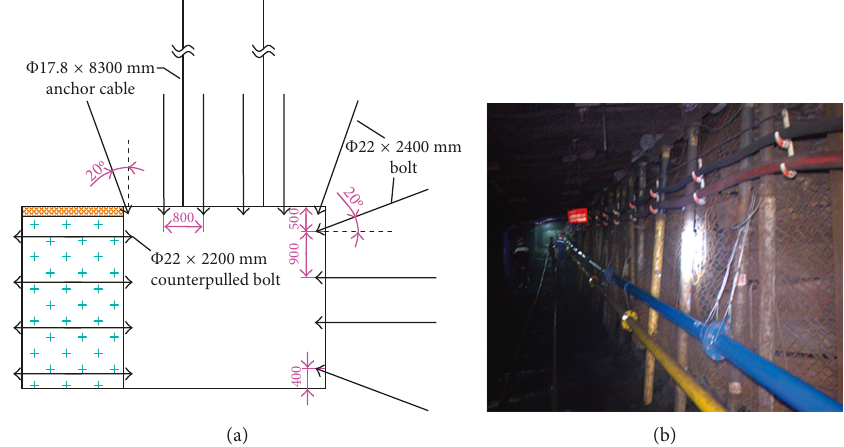
Figure 12: Roadway support design and effect. (a) Roadside support design scheme. (b) Roadside support effect.